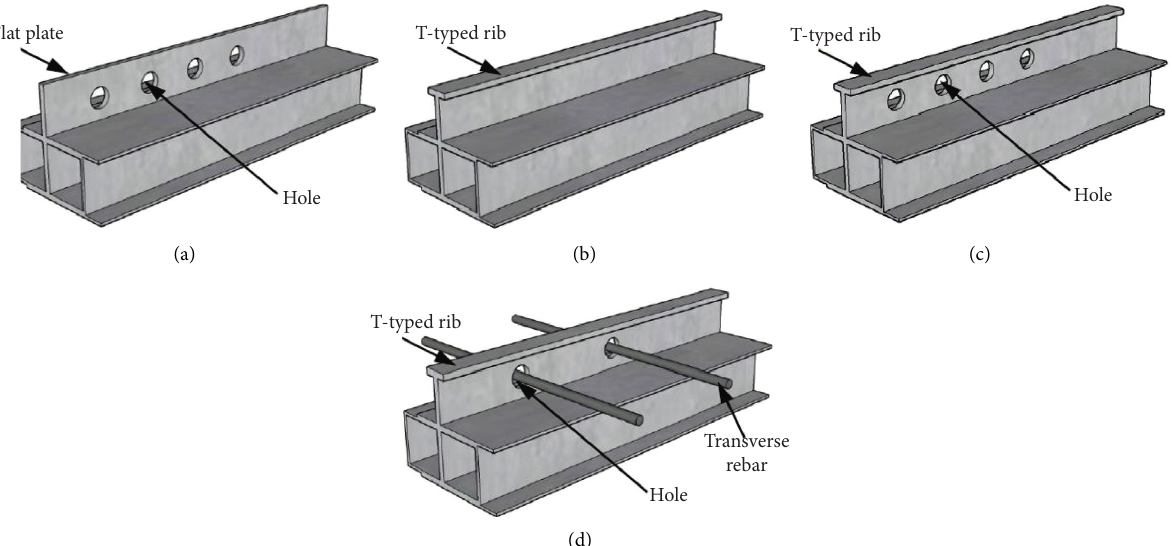
Figure 25: Configuration of GFRP shear connectors investigated by Huang.